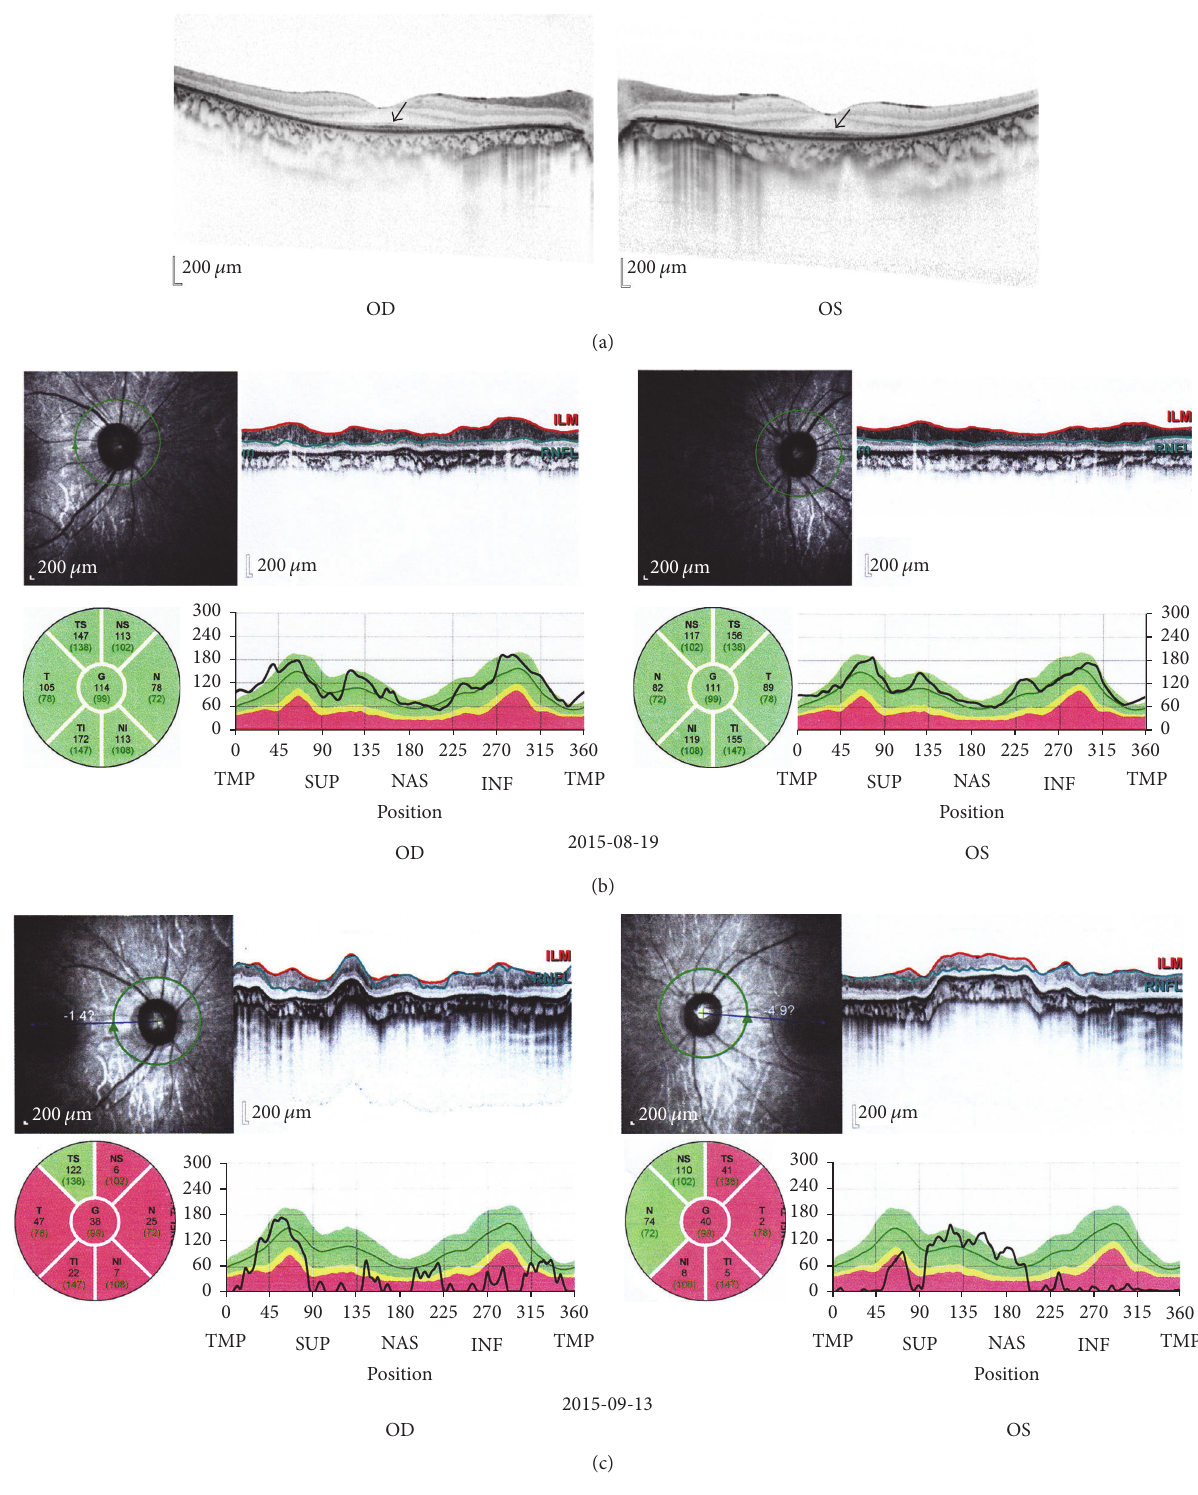
Figure 2: (a) shows thinning and atrophy of the outer retina and foveal sparing of the continuous ellipsoid zone of both eyes (arrows). (b) shows the RNFL thickness of both eyes was with of normal range on Aug. 19, 2015. (c) shows the RNFL thickness of both eyes became thinner in all quadrants on Sep. 13,